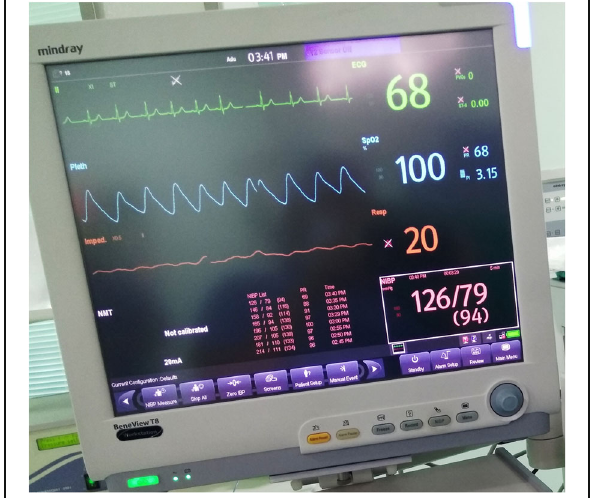
Fig. 2 Showing noninvasive respiratory support and volatile anesthetic agent (sedation) related